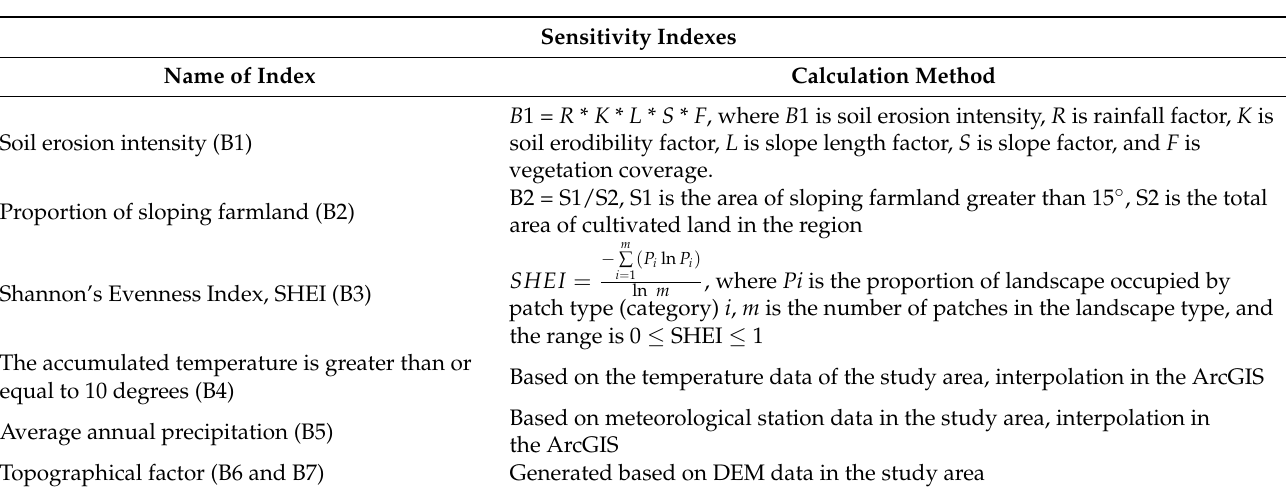
Table 3. Calculation method of sensitivity